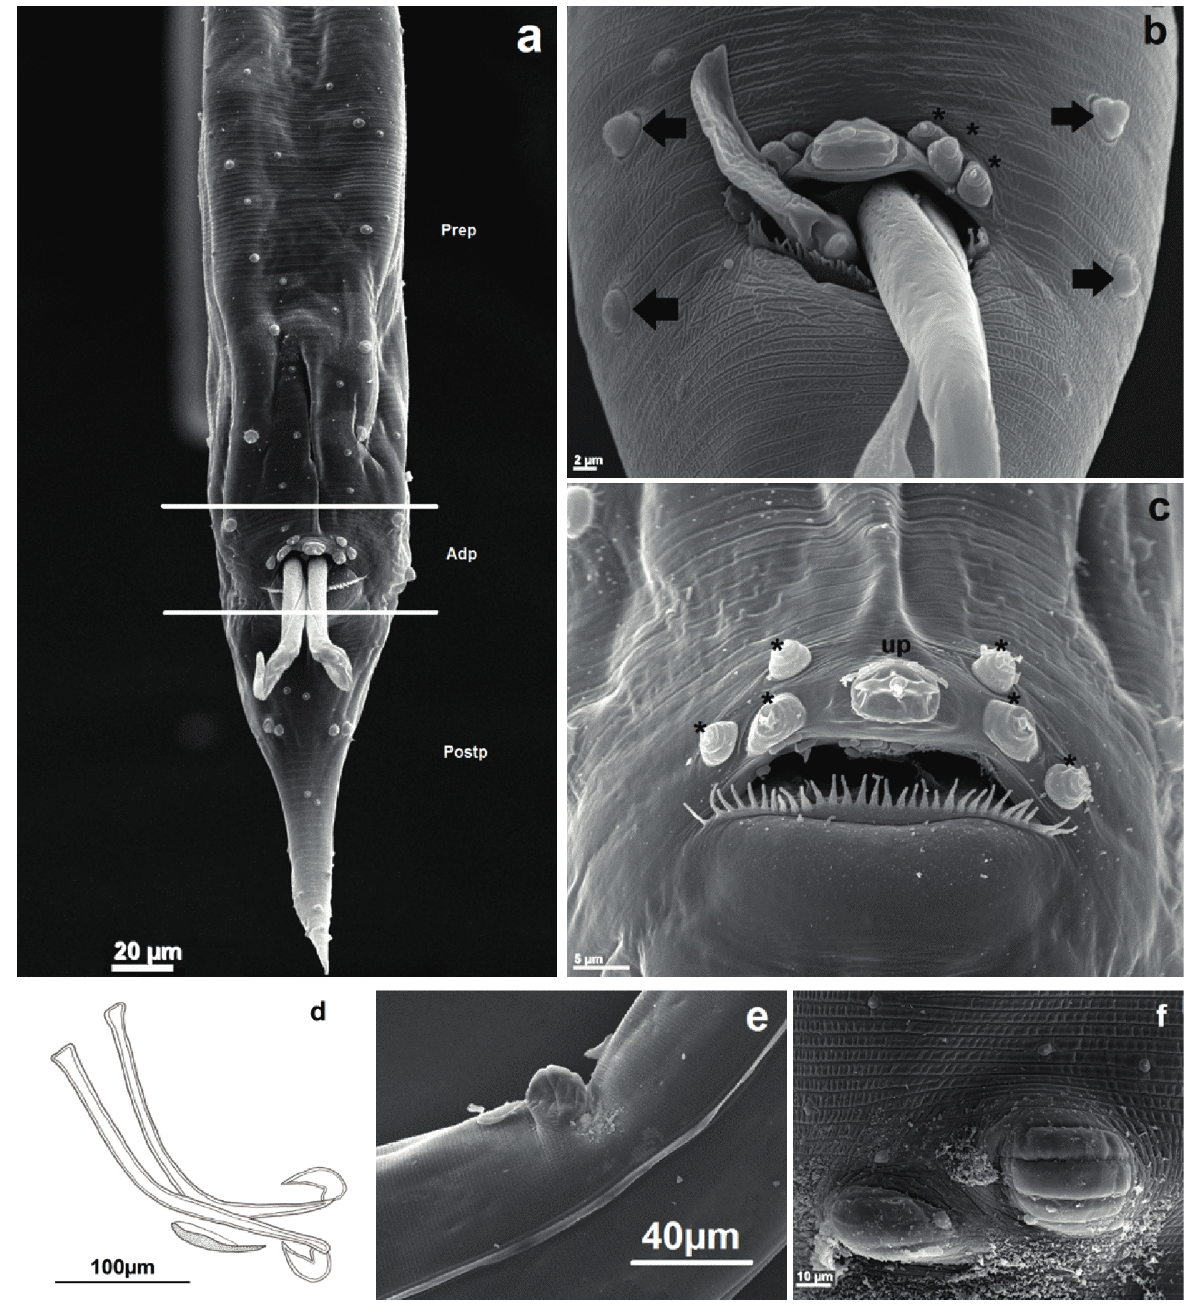
Figure 1 - Morphological characteristics of males and females of A. hylambatis studied in this study. (a) Posterior extremity in ventral view of male shows disposition of precloacal papillae (Prep), adcloacal papillae (Adp) and postcloacal papillae (Postp). (b) Detail of adcloacal papillae, arrows indicated lateral adcloacal papillae; asterisk indicated adcloacal papillae anterior to cloaca. (c) Disposition of adcloacal papillae in the anterior lip of cloaca; in the middle: large unpaired papilla (up), at each side of this, three papillae (3 pairs, asterisks). (d) Spicules and gubernaculum, lateral view. (e, f) Mamelon-like cuticular protuberances anteriorly to the vulva in lateral view ( e ), and in ventral view (f